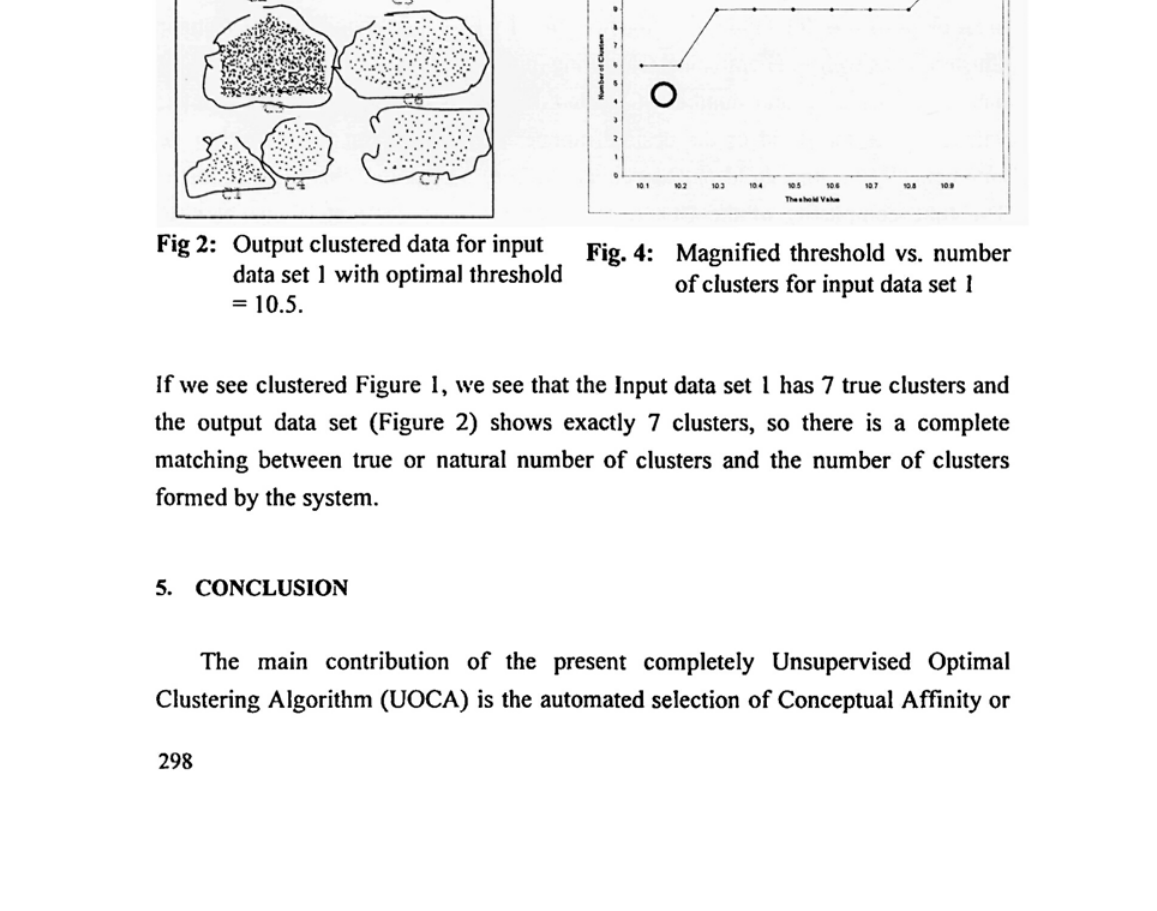
Fig. 3: Threshold vs. number of clusters for input data set 1